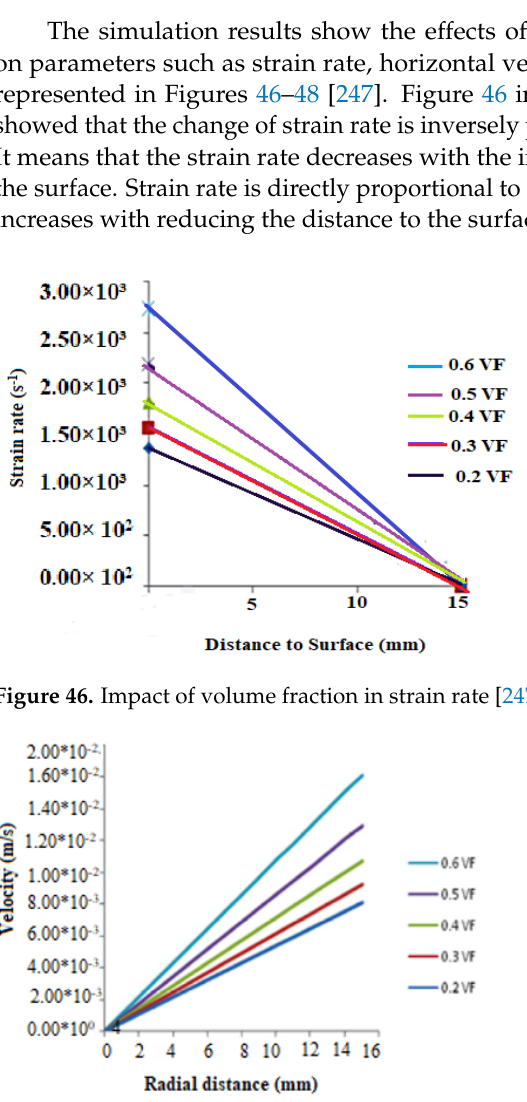
Figure 47. Impact of volume fraction in horizontal velocity. Figure 48 interpreted the simulation results, and it showed that the dynamic pressure of AFM media is directly proportional to the radial distance to the surface. It means that when the dynamic pressure of AFM media increases, the radial distance of abrasive grain from the surface increases. The dynamic pressure of AFM media is directly proportional to the material removal rate (MRR), so MRR increases with increasing the dynamic pres- sure of AFM media, and radial distance to the surface depends on the viscosity of AFM media.